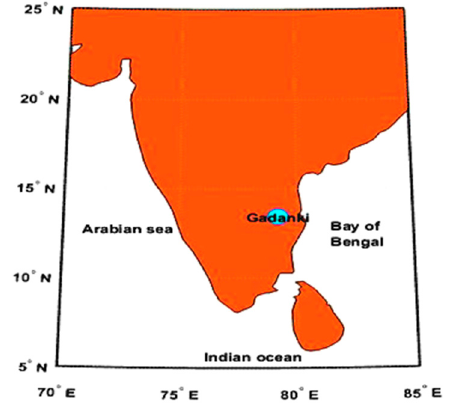
Figure 1. Latitude and longitude map location of the Gadanki (13.5 ◦ N, 79.2 ◦ E) region.